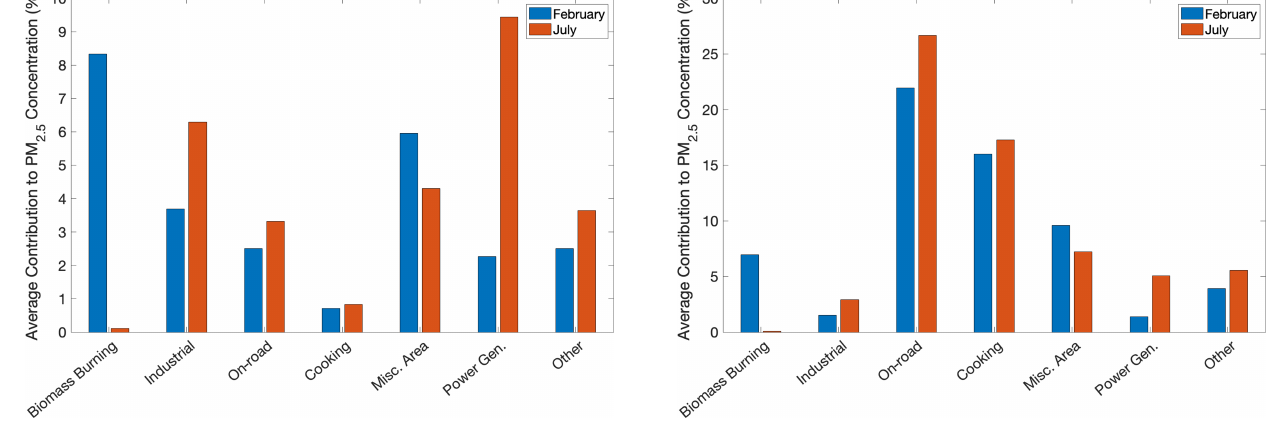
6 Exposure to PM 2 .